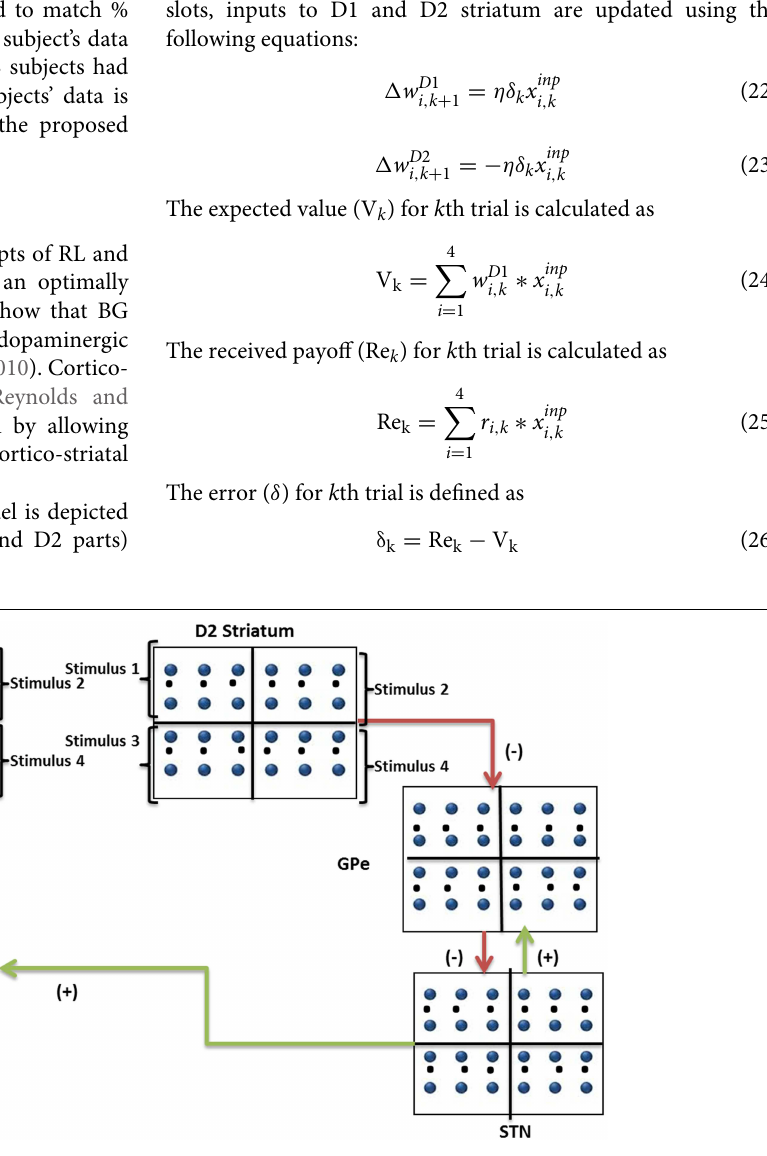
FIGURE 3 | Modeling the n-armed bandit task. The figure shows a pictorial representation of inputs to striatal, GPi, GPe, and STN networks (50 * 50) depicting D1 and D2 neuronal pools and their